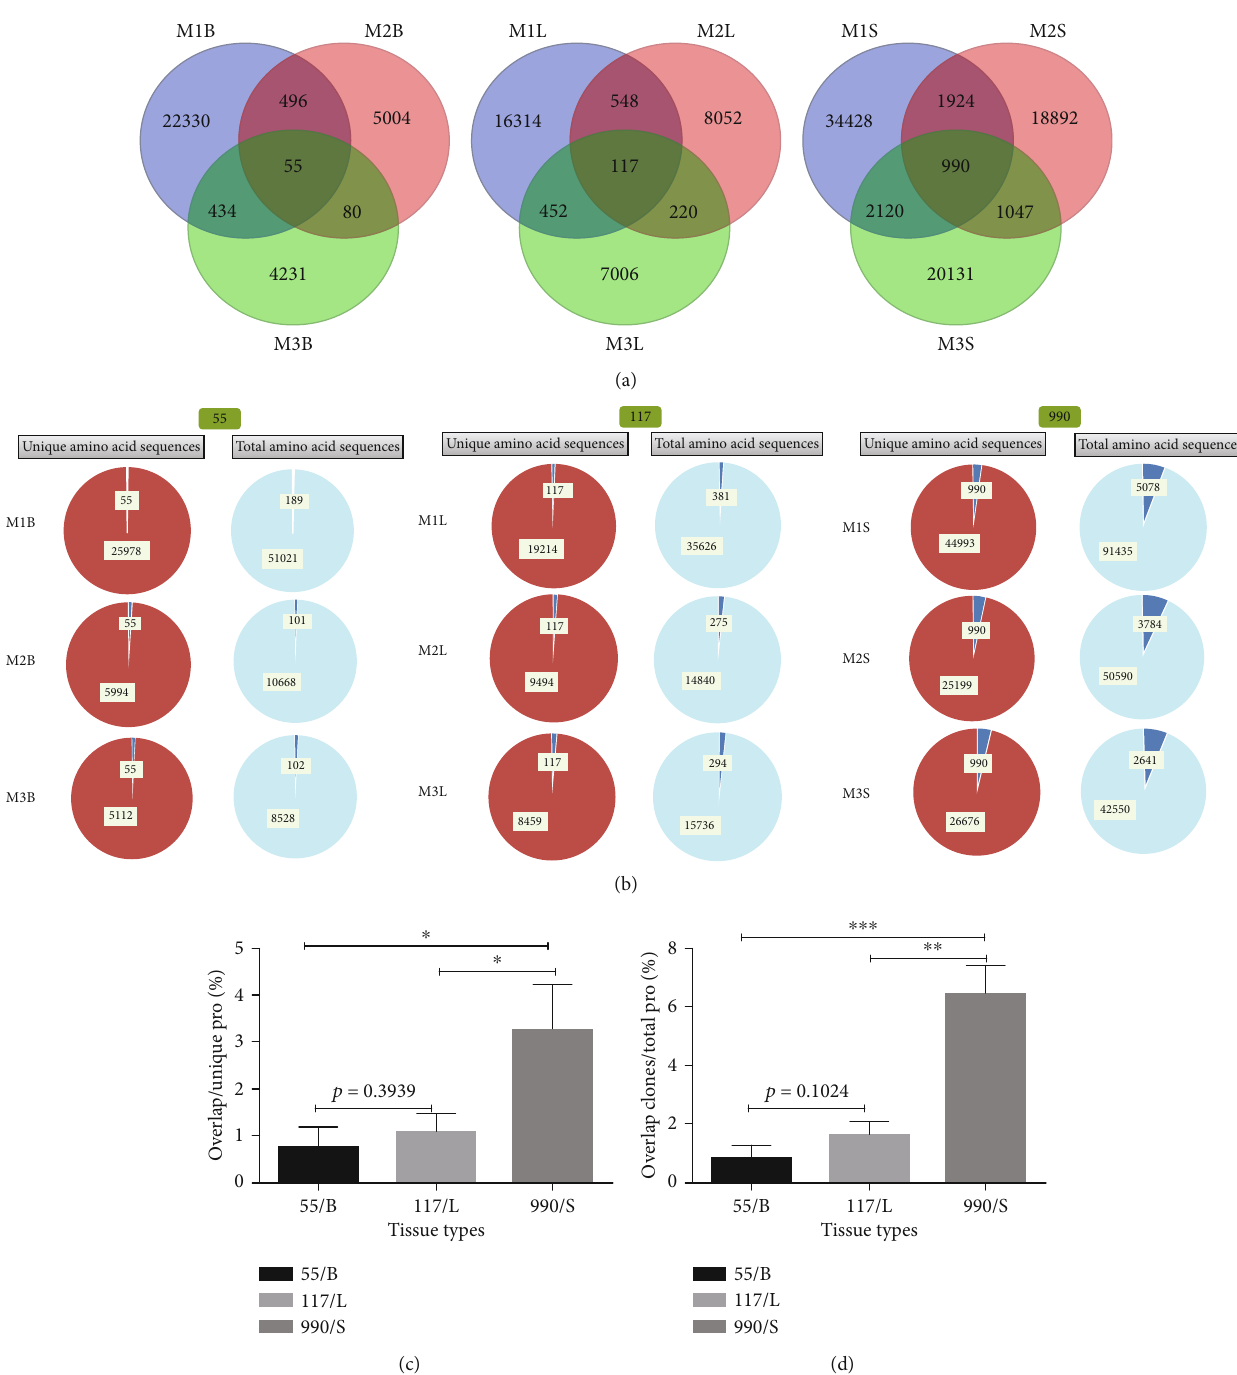
Figure 5: The number of public CDR3 sequences from CD4 + CD25 + T cells TCR β CDR3 repertoires among same tissues from three 4T1 tumor-bearing BALB/c mice (a); the number and ratio (b) and the statistical analysis (c) of public CDR3 sequences from their respective unique productive CDR3 repertoires and total productive CDR3 repertoires,